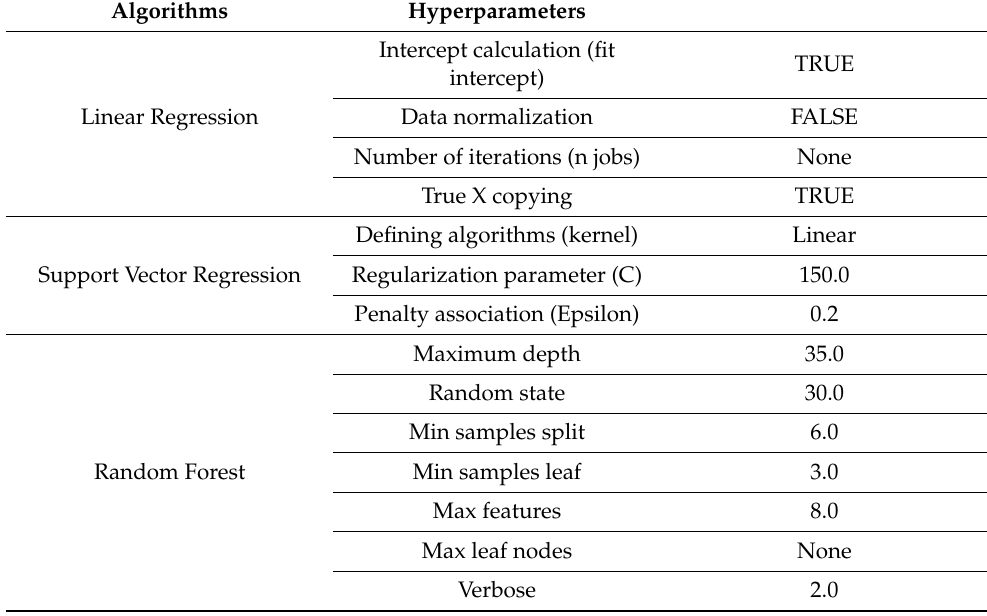
Table 2. Hyperparameters tuning of machine learning